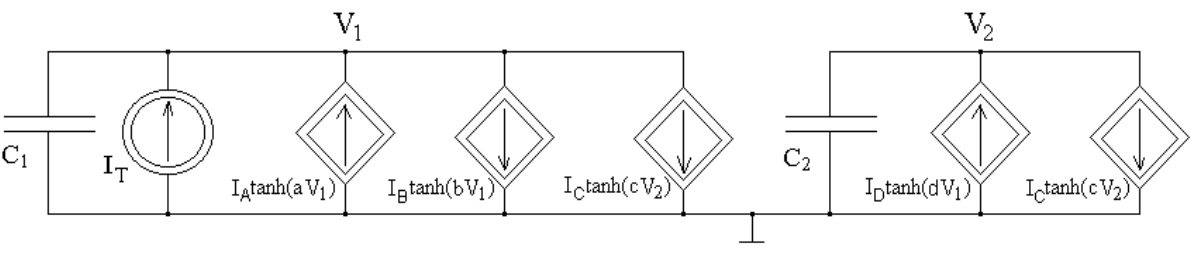
Figure 1. A circuit representation of the mathematical model of an